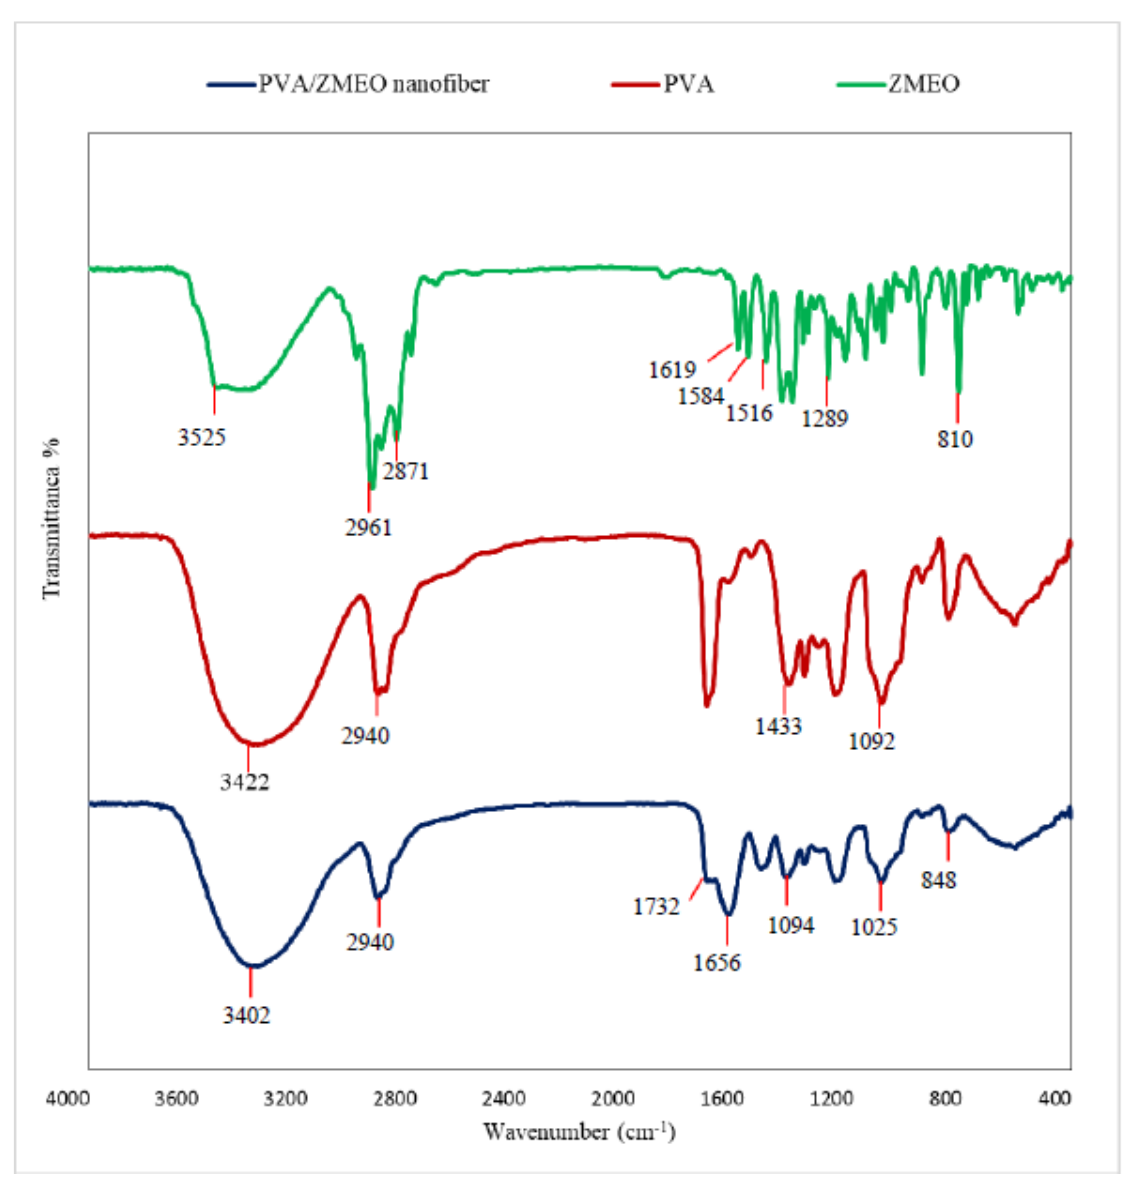
Figure 2. Fourier-transform infrared (FTIR) spectra for PVA powder, ZM essential oil, PVA/ZMEO fiber. Table 2. Parameters of DSC thermogram for PVA powder, ZM essential oil, PVA/ZMEO fiber. T eo ( ◦